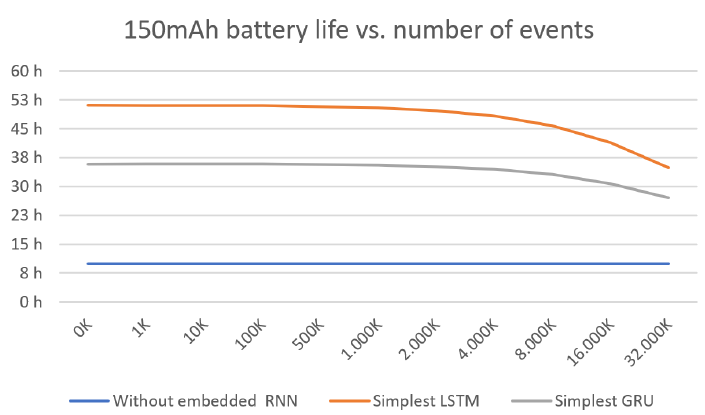
Figure 8. Battery life with the power consumption estimation for each device and feasible real-time RNN